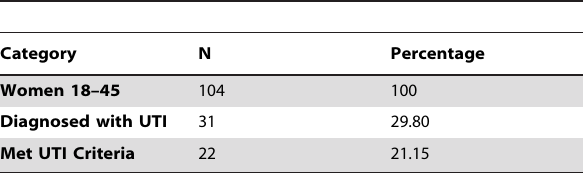
Table 3. Comparison of UTI diagnosis based on study criteria vs clinical diagnosis by health care providers on the brigades.